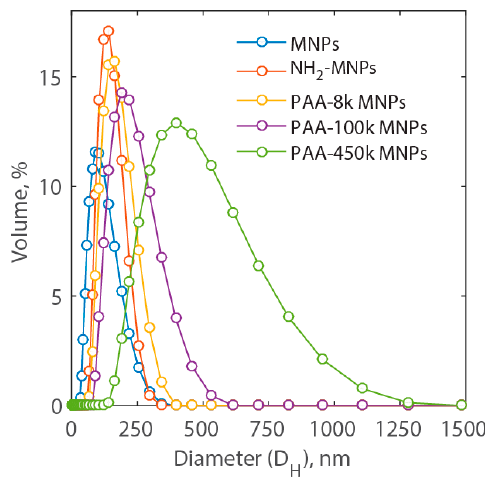
Figure 2. Hydrodynamic diameter ( D H ) distribution of MNPs, NH 2 -MNPs, PAA-8k-MNPs, PAA- 100k-MNPs, and PAA-450k-MNPs in DI-H 2 O.